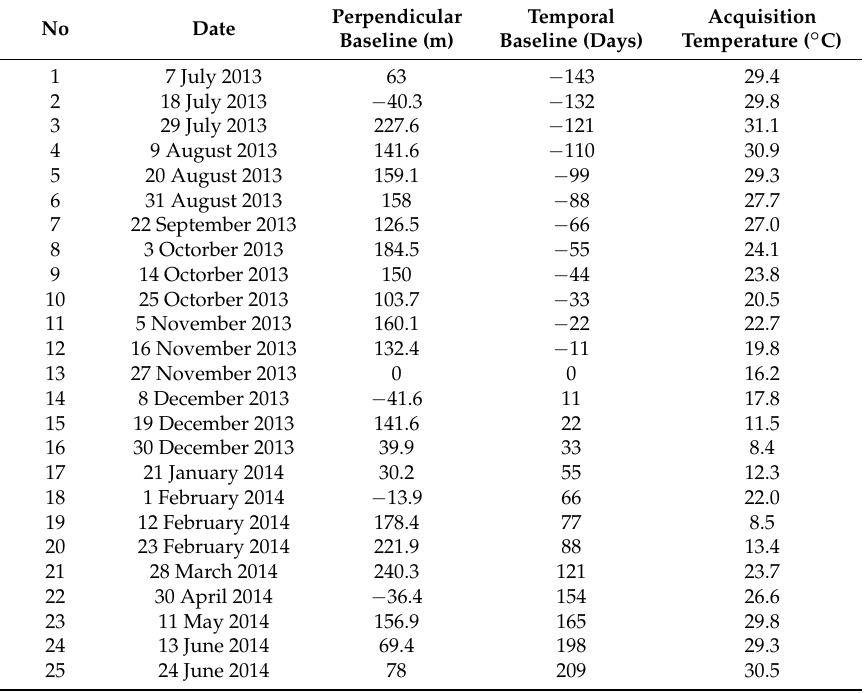
Figure 13. ( a ) The optical image of the Tsing Kwai Highway (TKH), the blue rectangles represent the locations of expansion joints; ( b ) the SAR amplitude image of the TKH; and, ( c ) the coverage of TerraSAR-X images in the Google Map (red rectangle), the yellow star indicates the location of the TKH. Table 2. Basic information of TerraSAR-X images in Hong Kong.